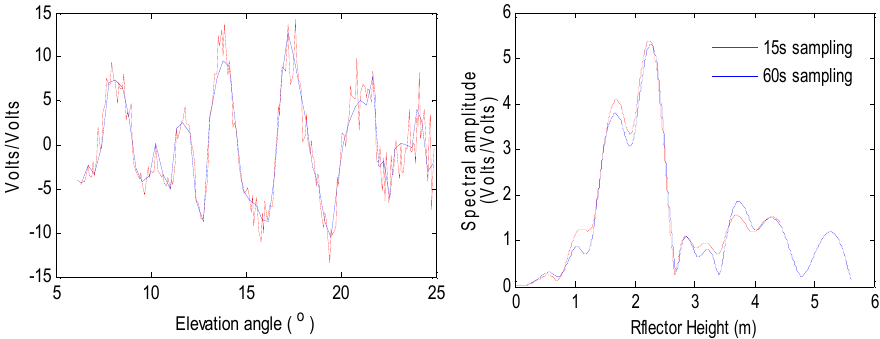
Figure 15. Comparison of 15 s and 60 s sampling multipath patterns and Lomb Scargle Periodograms at AB39.